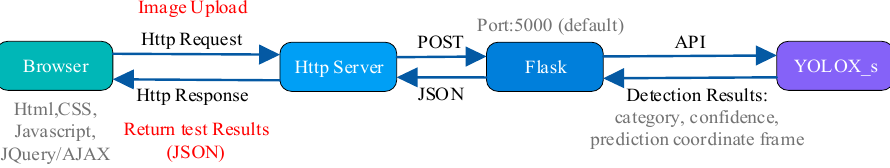
Figure 6. Flask-based Web-side YOLOX_s detection system framework.